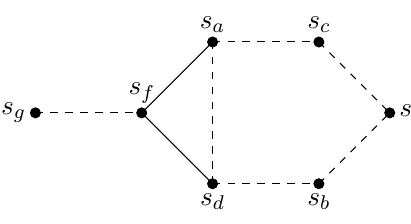
Figure 18 . Coxeter diagram, (cid:6)( P 1 ), for the the Coxeter group associated with the pentagonal prism. The vertices of the graph are labelled with the corresponding generator of the Coxeter group. The faces F f and F g of the Coxeter polyhedra (corresponding to the generators s f and s g ) are the pentagonal faces of the prism, the faces F a (cid:0) F e are the quadrilateral faces. interaction strengths in the Hamiltonian scale as max (cid:0) (cid:1) (cid:1) = (cid:10) k H k 6 . The perturbation gadget techniques require that (cid:15); (cid:17) = 1 = poly((cid:1) L bulk